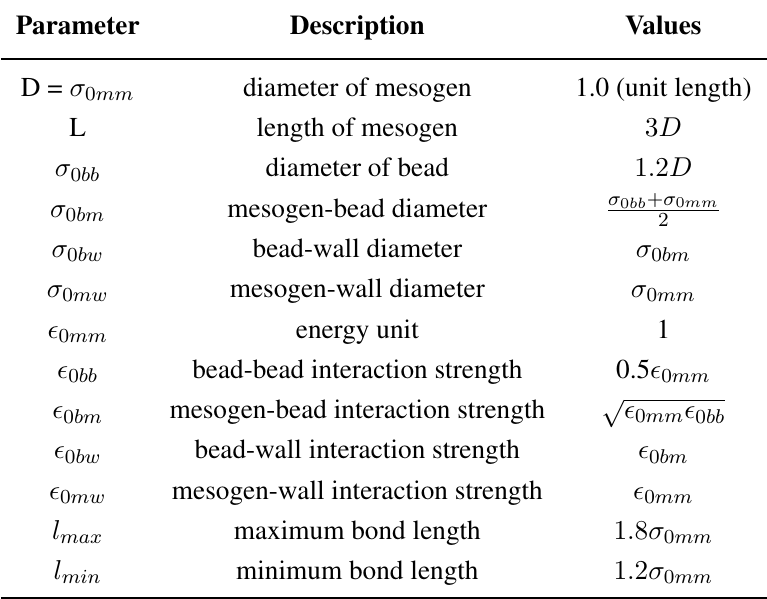
Table 1. Force field parameters for the coarse-grained liquid crystalline dendrimer (LCDr)